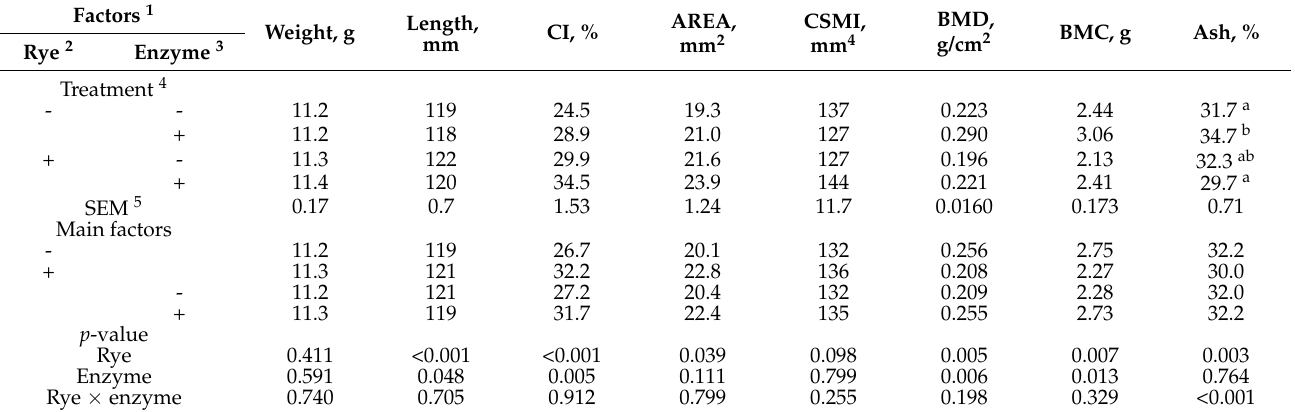
Table 6. The effect of dietary 25% rye inclusion and xylanase supplementation (200 mg/kg of feed) on hens’ tibial geometric properties at the end of the laying cycle.